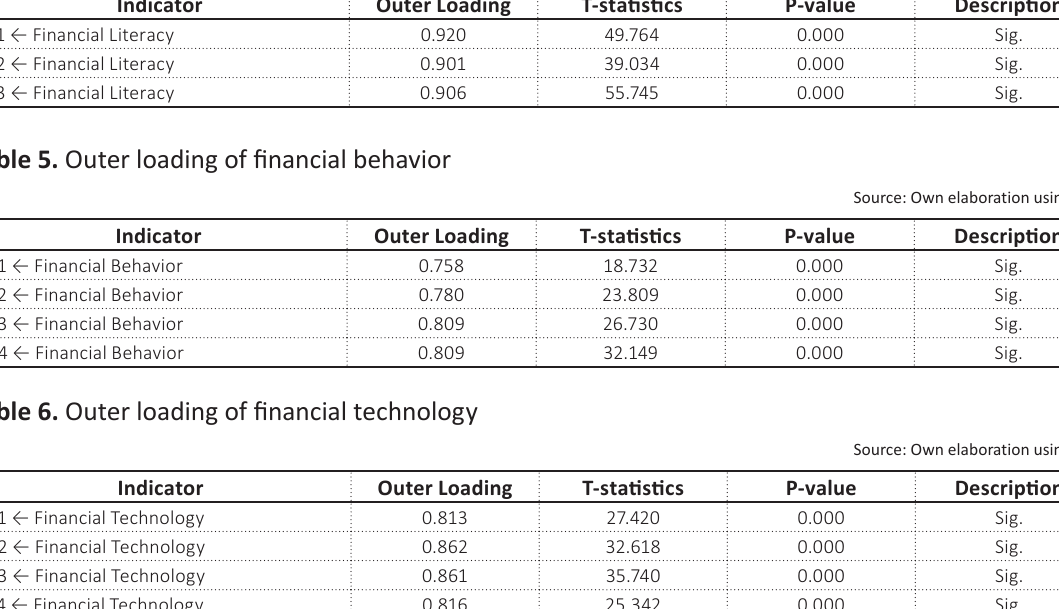
Table 4. Outer loading of financial literacy